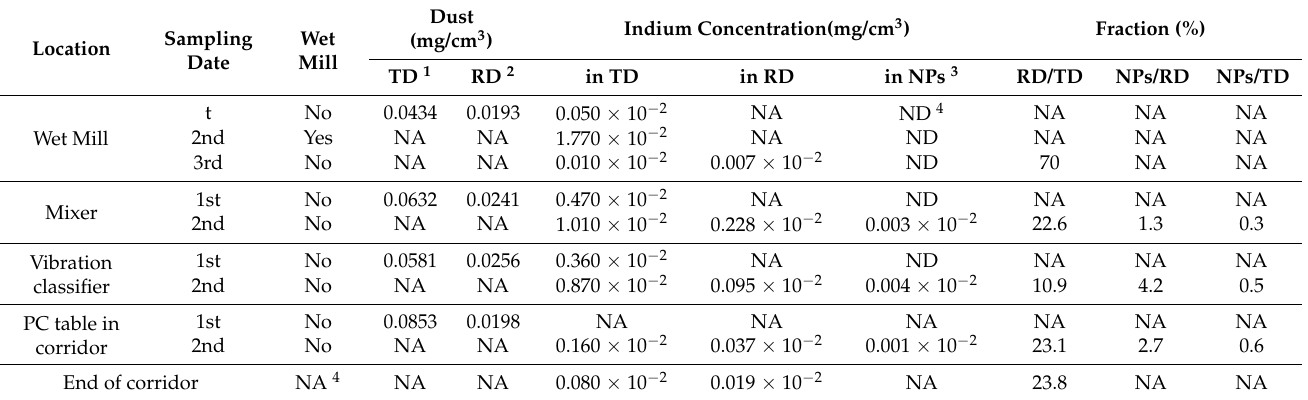
Table 2. Indium concentrations and fraction (%) of RD and NPs in